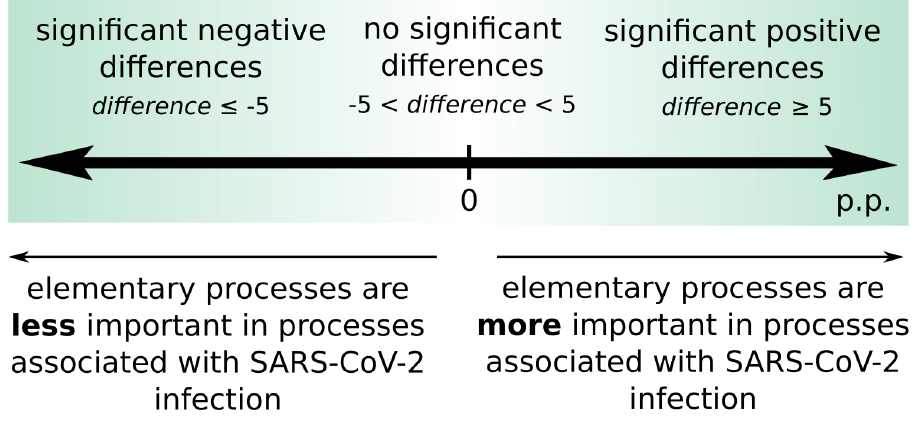
Figure 4. Interpretation of the positive and negative differences including their